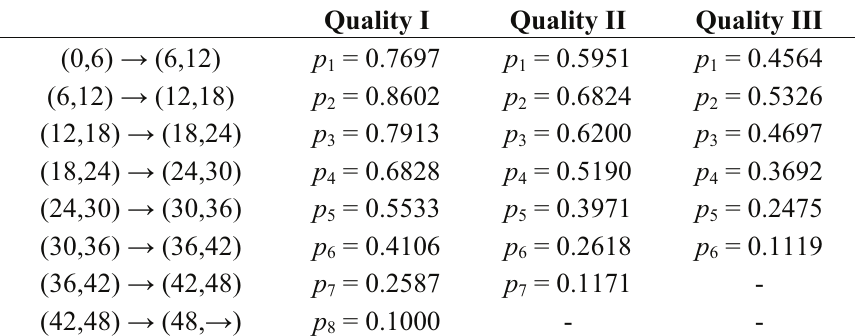
Table 1. Transition probabilities between diameter classes for each